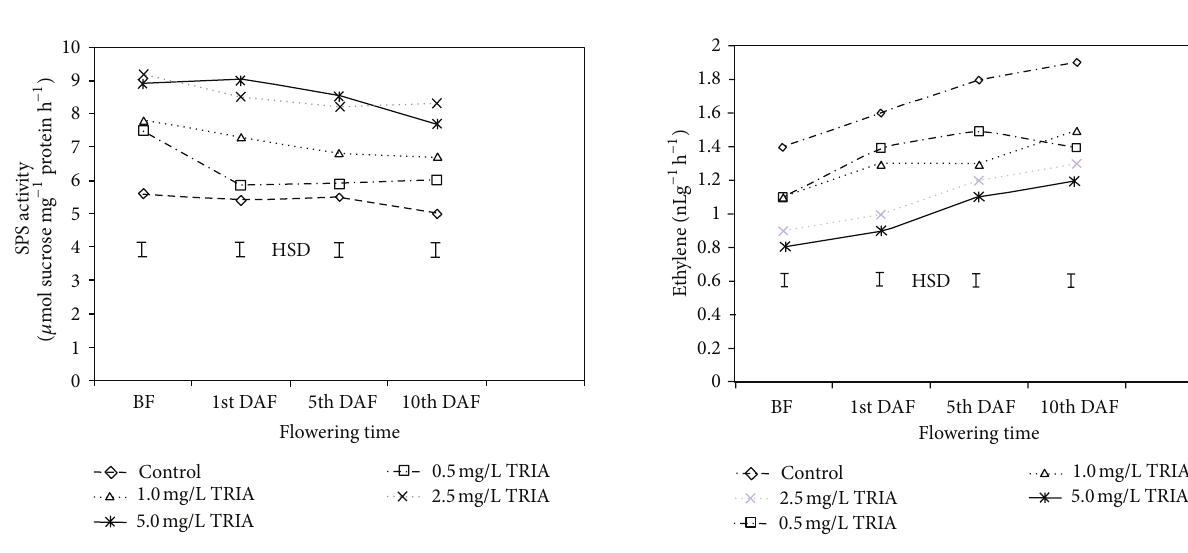
Figure 6: The effect of TRIA treatments on ethylene production of Bougainvillea glabra leaves. BF: before flowering, DAF: day after